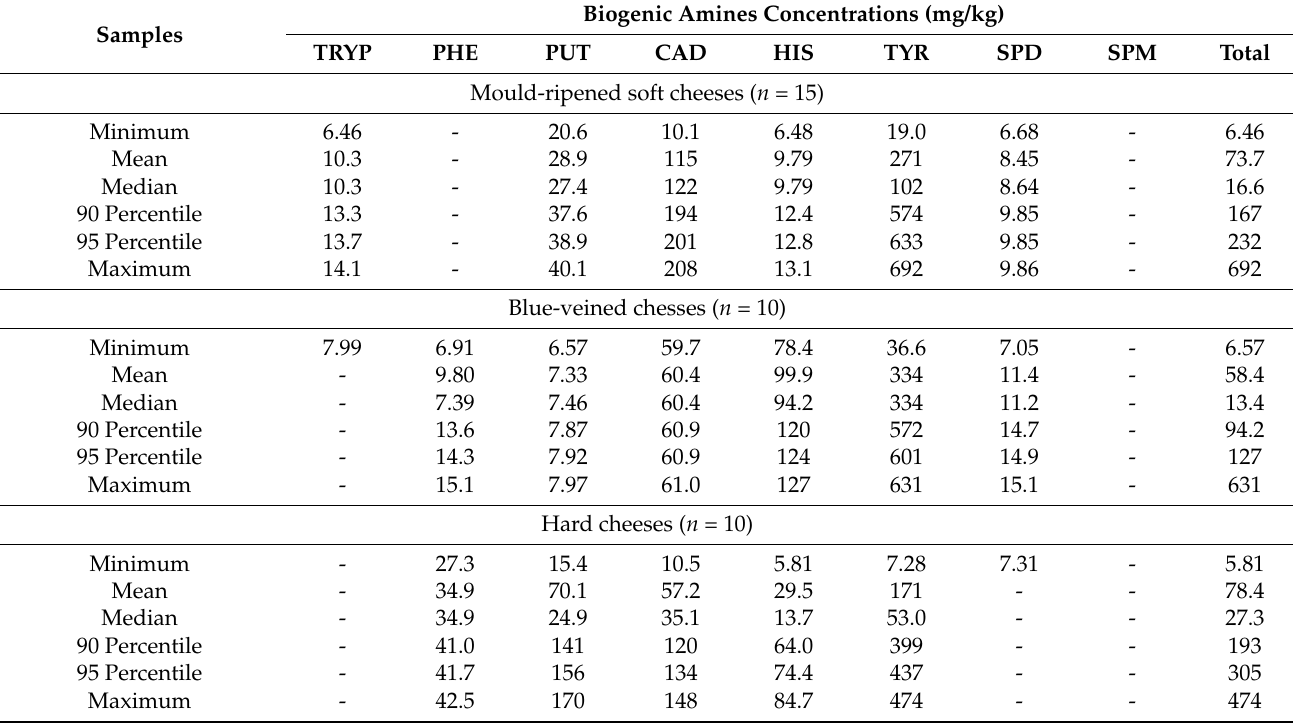
Table 6. Statistical evaluation of biogenic amines concentration within three cheese type